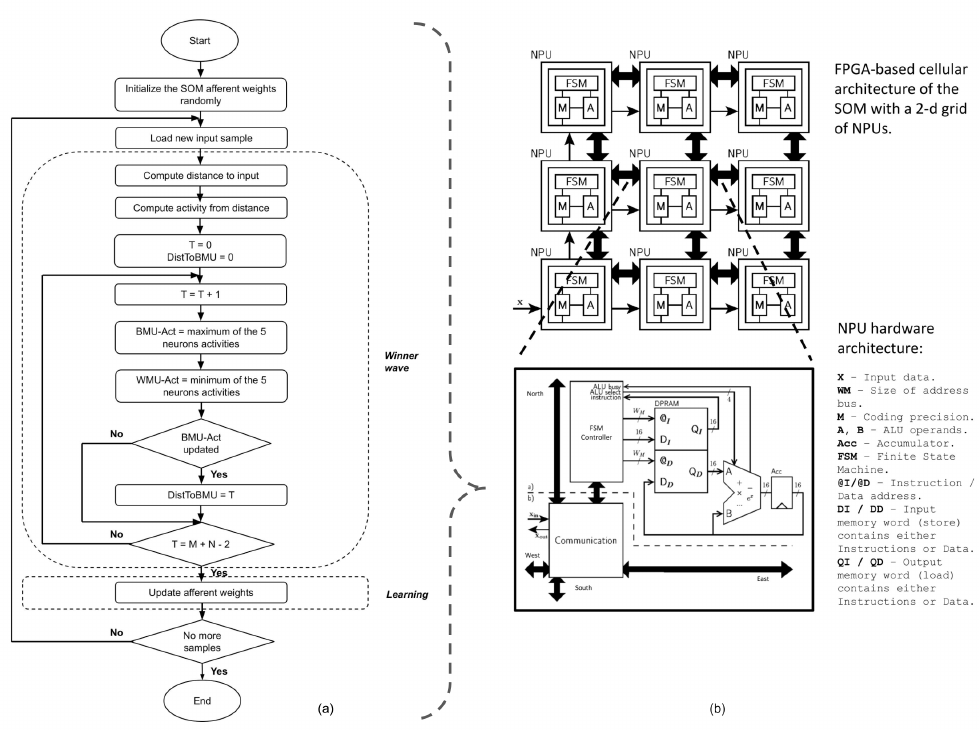
Figure 3. ( a ) Best Matching Unit (BMU) and Worst Matching Unit (WMU) distributed computing flowchart for each neuron. This flowchart describes the Self-Organizing Map (SOM) learning, but the winner wave is applied the same way for all steps of the multimodal learning while the learning part can be replaced by Hebbian-like learning or inference; ( b ) Neural Processing Units (NPUs) grid on FPGA